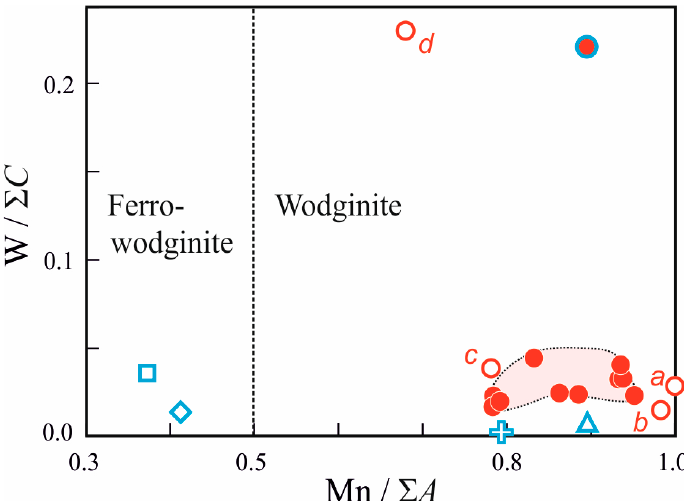
Figure 4. Compositions of tungsten-bearing wodginite in Li-F granites from the Kester deposit and from other deposits and wodginite-group minerals in the world in the quadrilateral of wodginite classification Mn/ Σ A versus W/ Σ C (atomic proportions). Σ A , Σ C —the sums of cations in positions A (Mn 2+ , Fe 2+ , Li, Ca) and C ( B Ta, Nb, W). For symbols, see Figure 3.